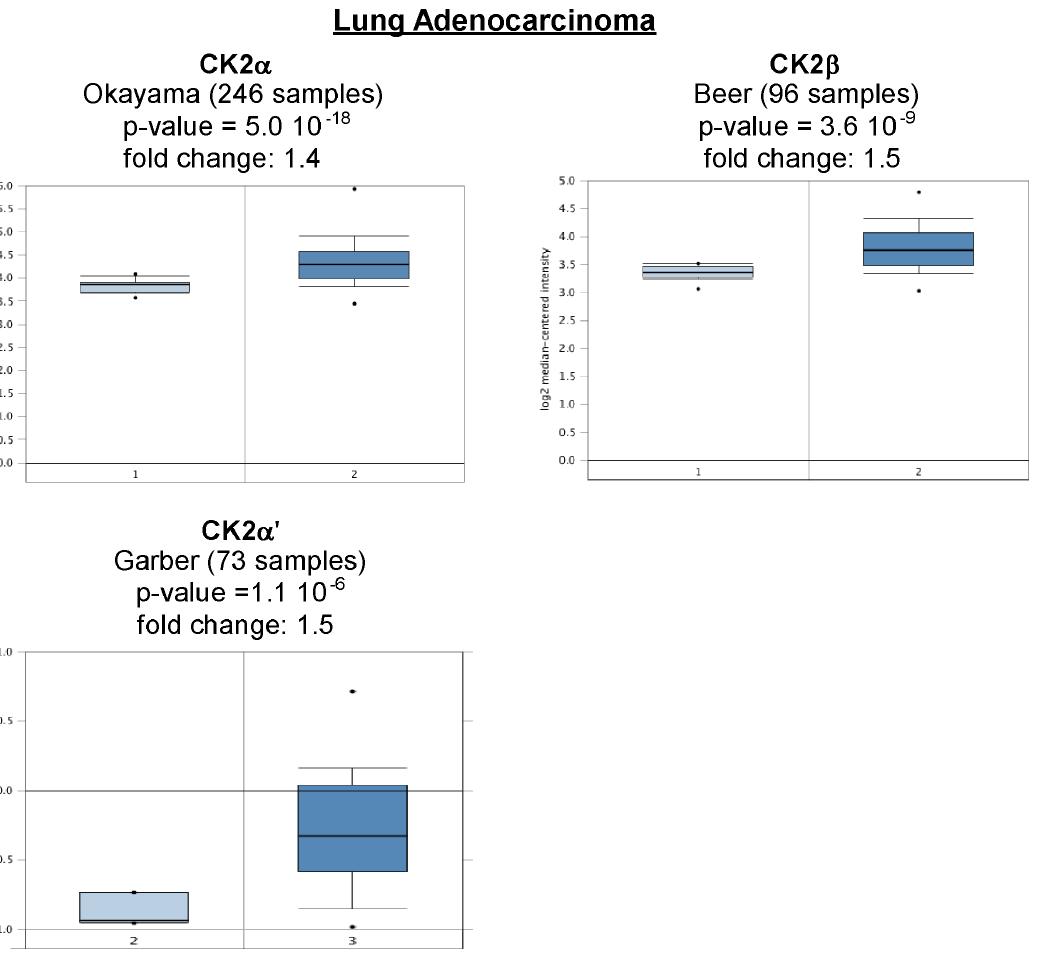
Fig. 2. CK2 gene analysis in lung cancer (Oncomine database). Box plots derived from gene expression data in Oncomine comparing expression of a specific CK2 gene in normal (left plot) and lung cancer tissue (right plot). Only lung adenocarcinoma is